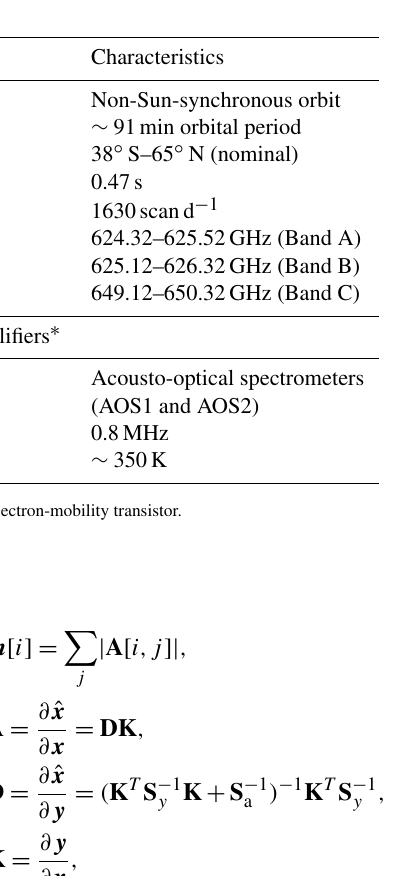
Table 1. SMILES characteristics.